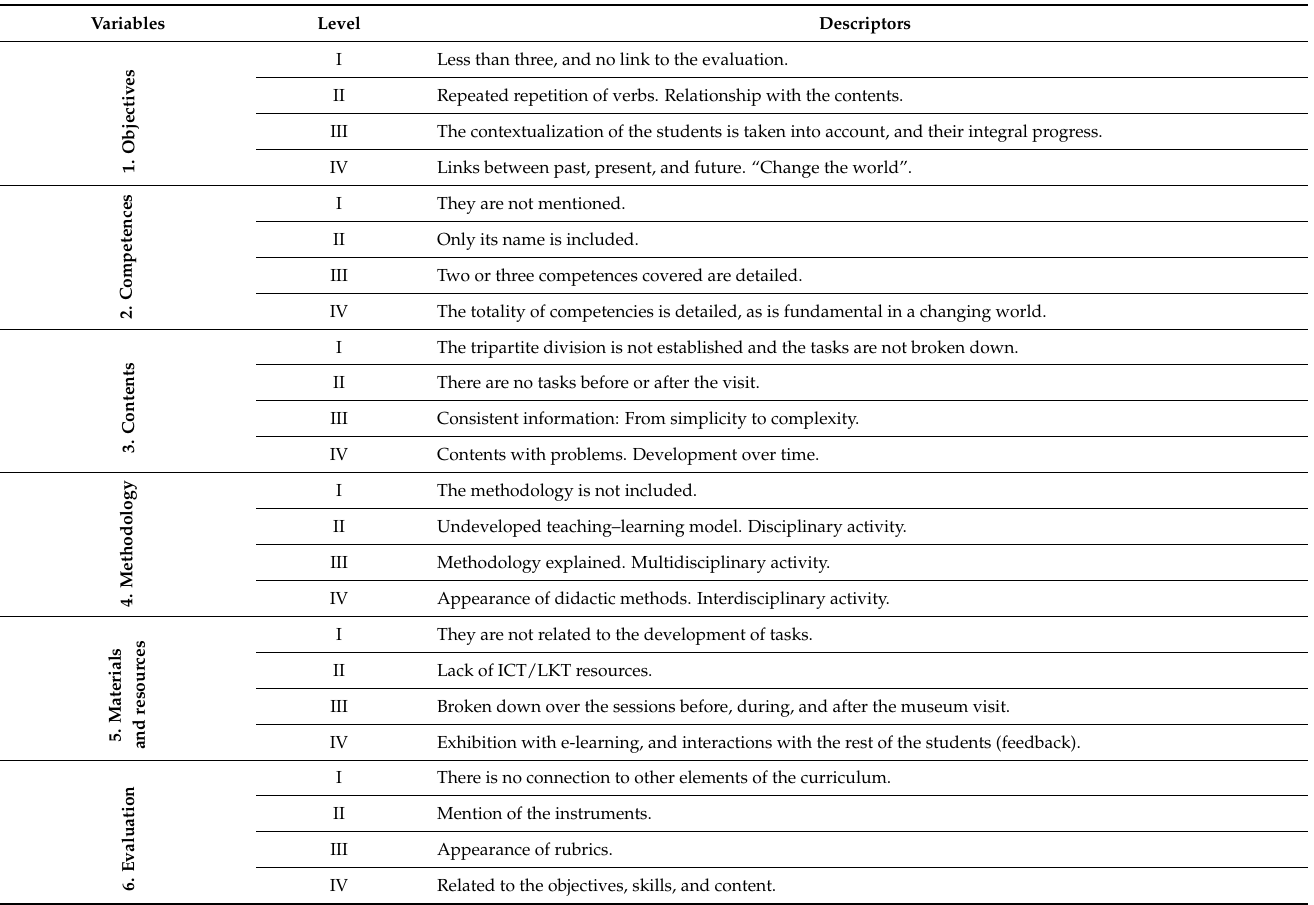
Table A1. Rubric for evaluating teaching